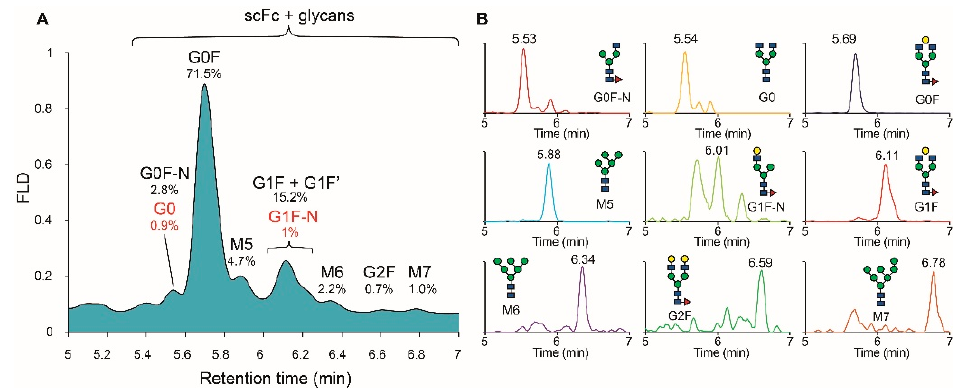
Figure 3. Zoom of the glycosylated scFc subunit of adalimumab in HILIC ‐ MS analysis ( A ) and ( B ) the extracted ion chromatograms (XIC) of the scFc subunit carrying the identified glycans. Relative glycan abundance levels provided for the scFc subunit carrying the glycoforms and determined based on the integrated XIC profiles ( n = 3). Glycan nomenclature: N ‐ acetyl glucosamine (blue), fucose (red), mannose (green), galactose (yellow).